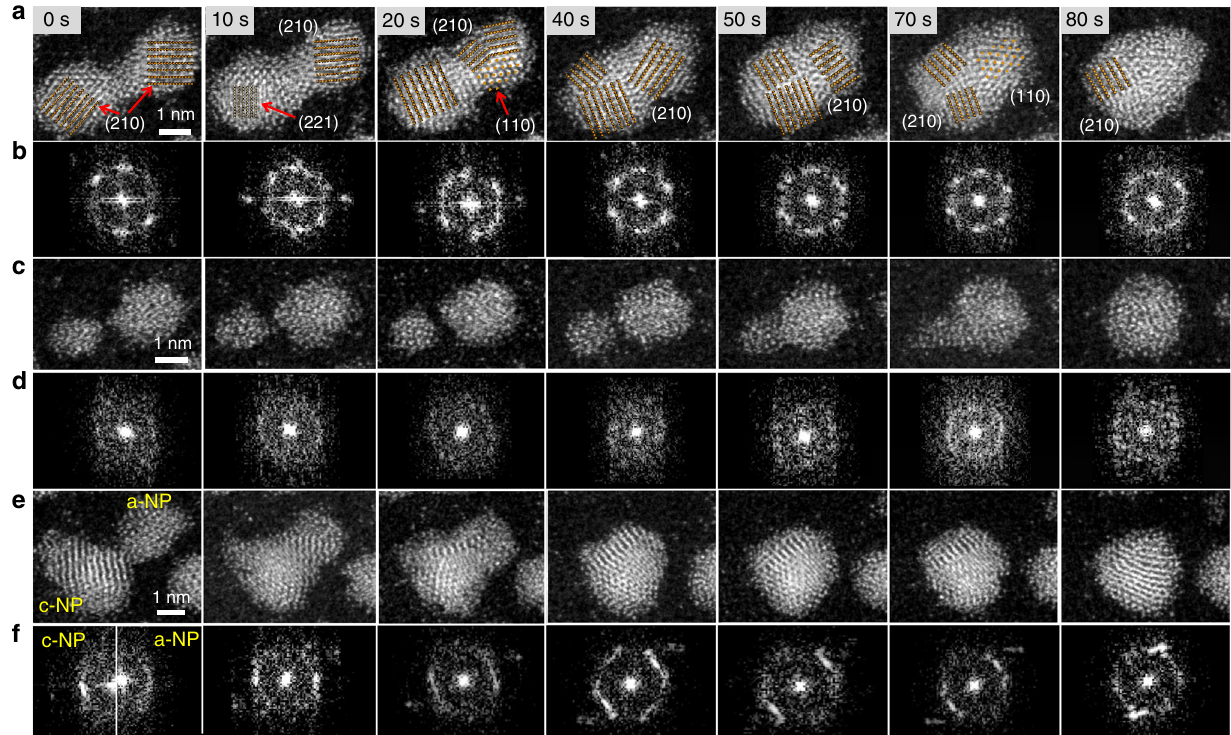
Fig. 5 Details of evolution of the three coalescence processes upon the time. A series of Cs-STEM images with the irradiation times as labeled (Corresponding to the three NP pairs in Fig. 4). a , c , e The coalescence of the c-NP, a-NP and a-c-NP pairs, respectively. b , d , f The corresponding FFT of the c-NP, a-NP and a-c-NP pairs, respectively. To show the rotation of the c-NP pair, the crystal planes are marked in a . The separated two parts in f at 0 s refer to the FFT of the c-NP and a-NP in the a-c-NP pair, respectively